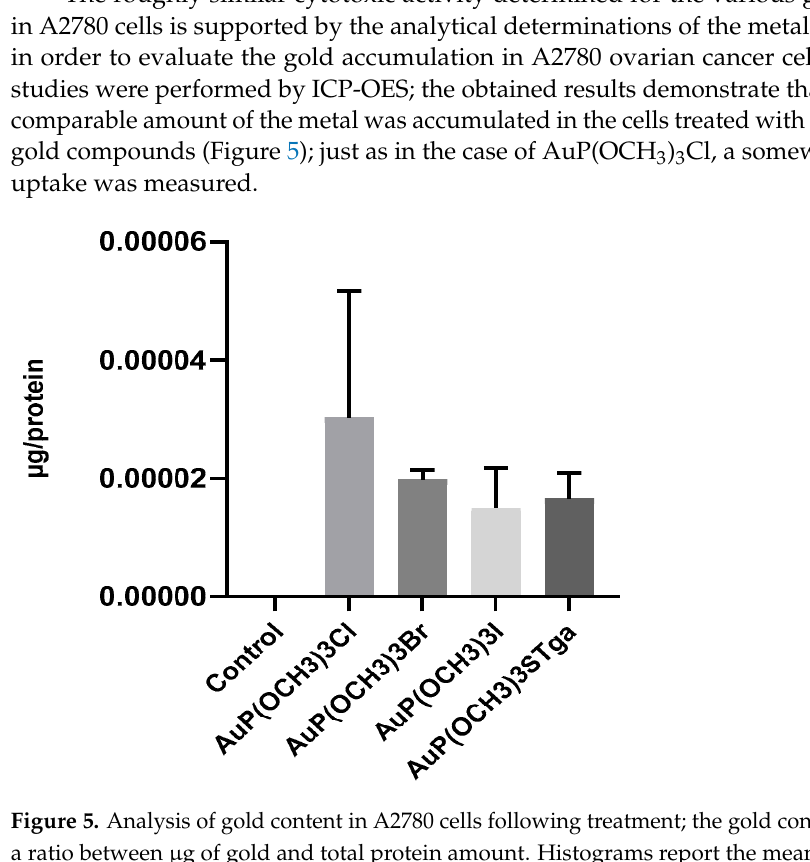
Table 2. In vitro cytotoxicity of the investigated compounds against A2780, A2780R and SKOV-3 ovarian cancer models. IC 50 ( µ M) 1 ± SD.